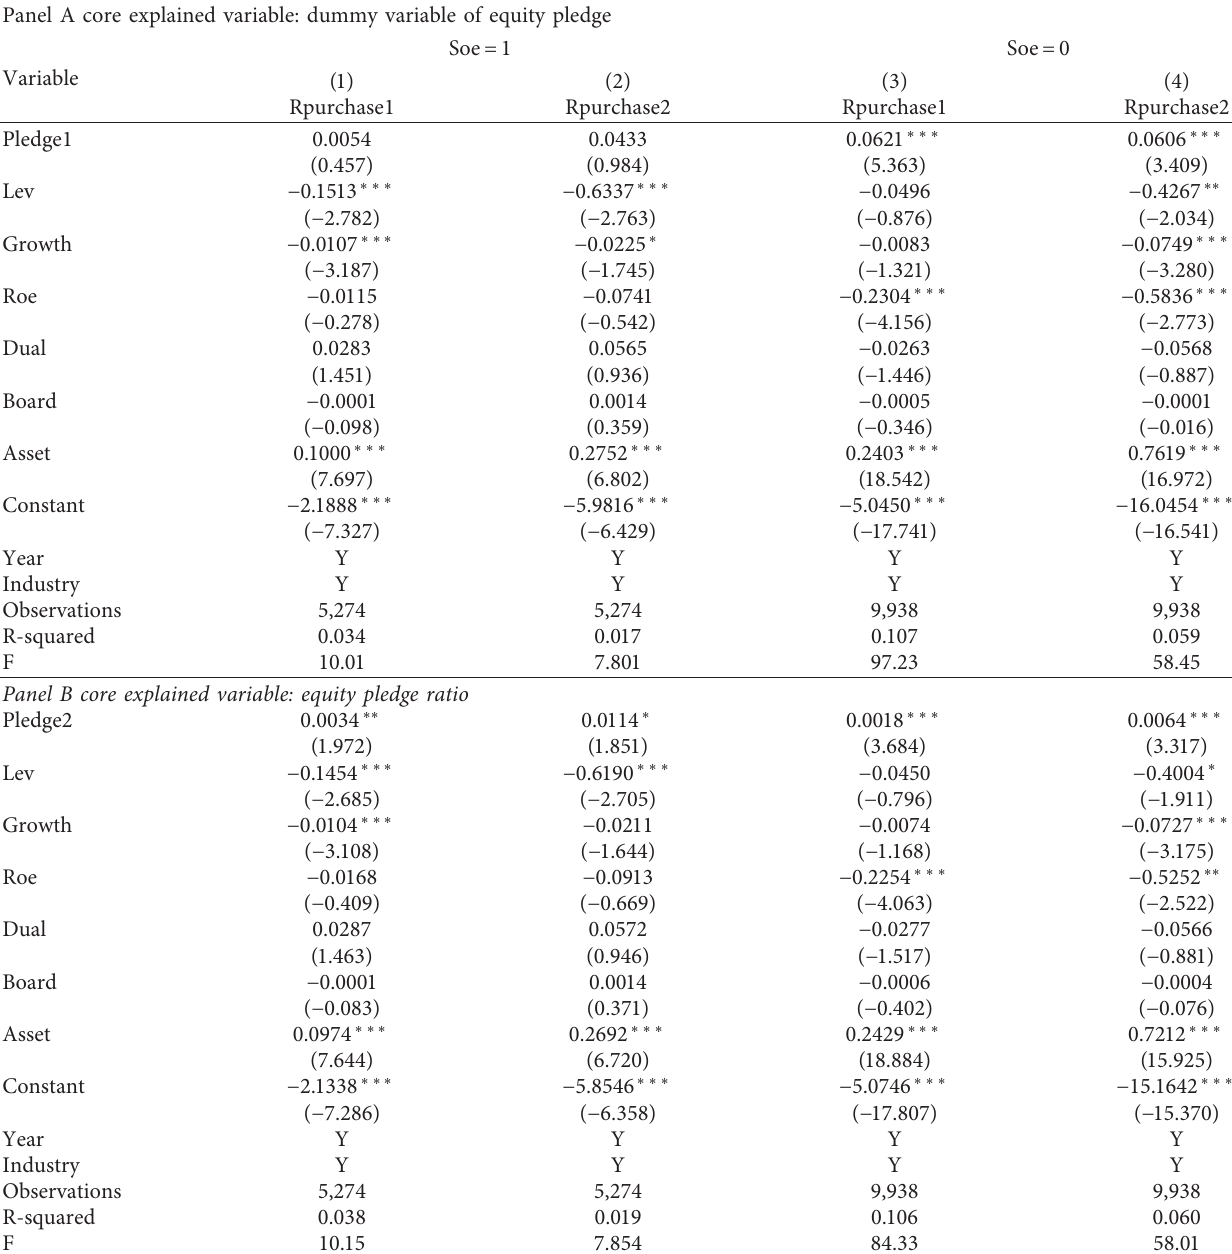
Table 7: Regression results of equity nature, controlling shareholders’ equity pledge, and listed companies’ stock repurchase. Panel A core explained variable: dummy variable of equity pledge Variable